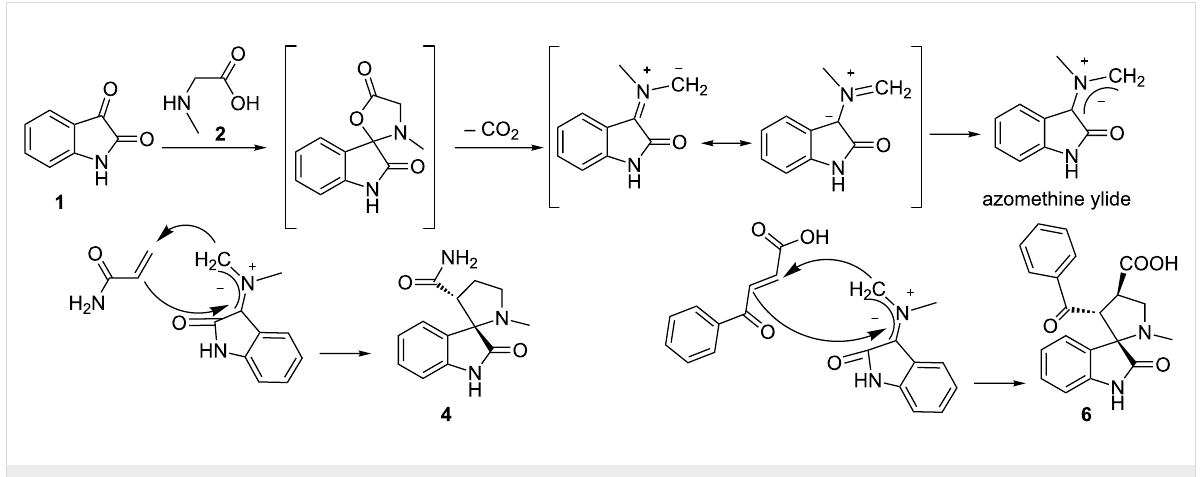
Scheme 1: The mechanism of the regioselective synthesis of compounds 4 and 6 .